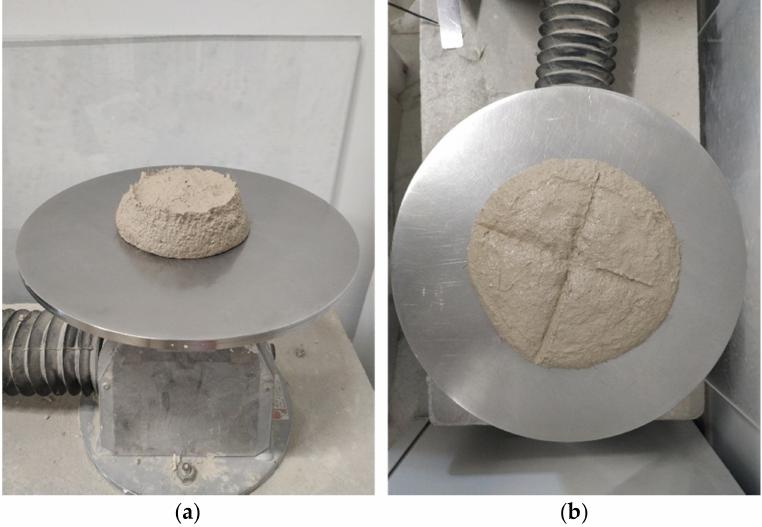
Figure 6. Slump test on fresh mortar. ( a ) The specimen just removed from the mold; ( b ) the two orthogonal diameters measured after the table was